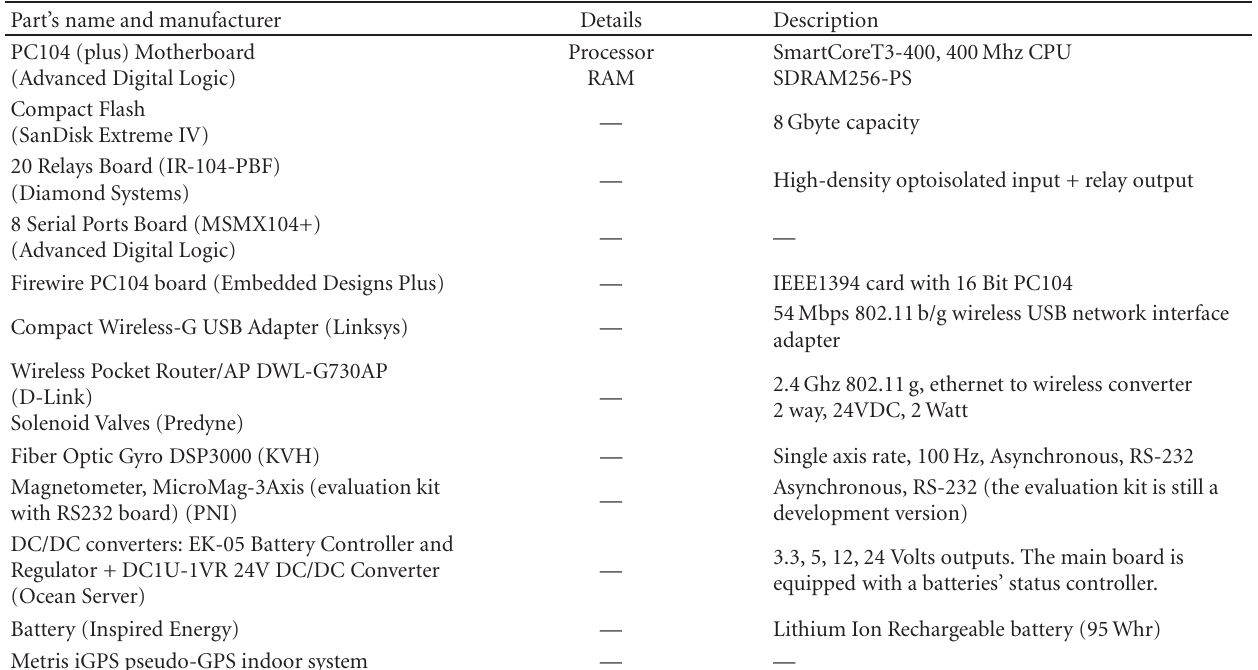
Table 1: Electronics hardware